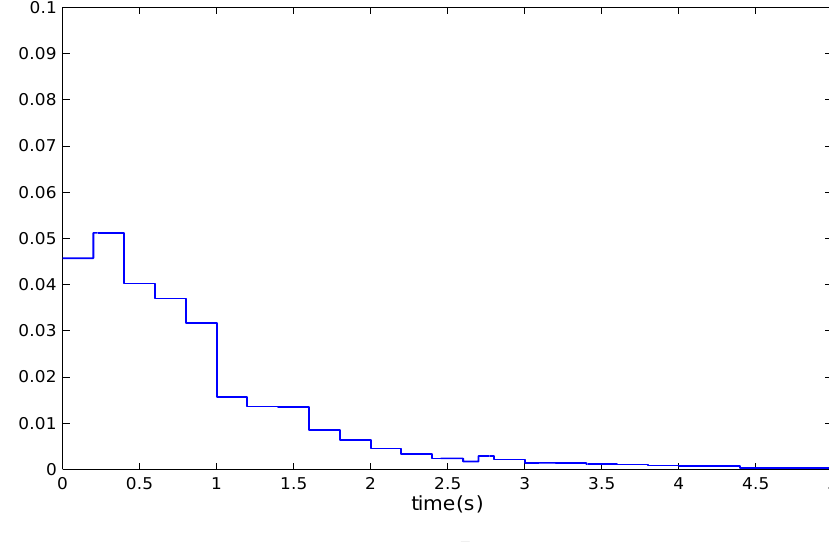
Fig. 5. The evolution of ˜ x T ( k ) α of system